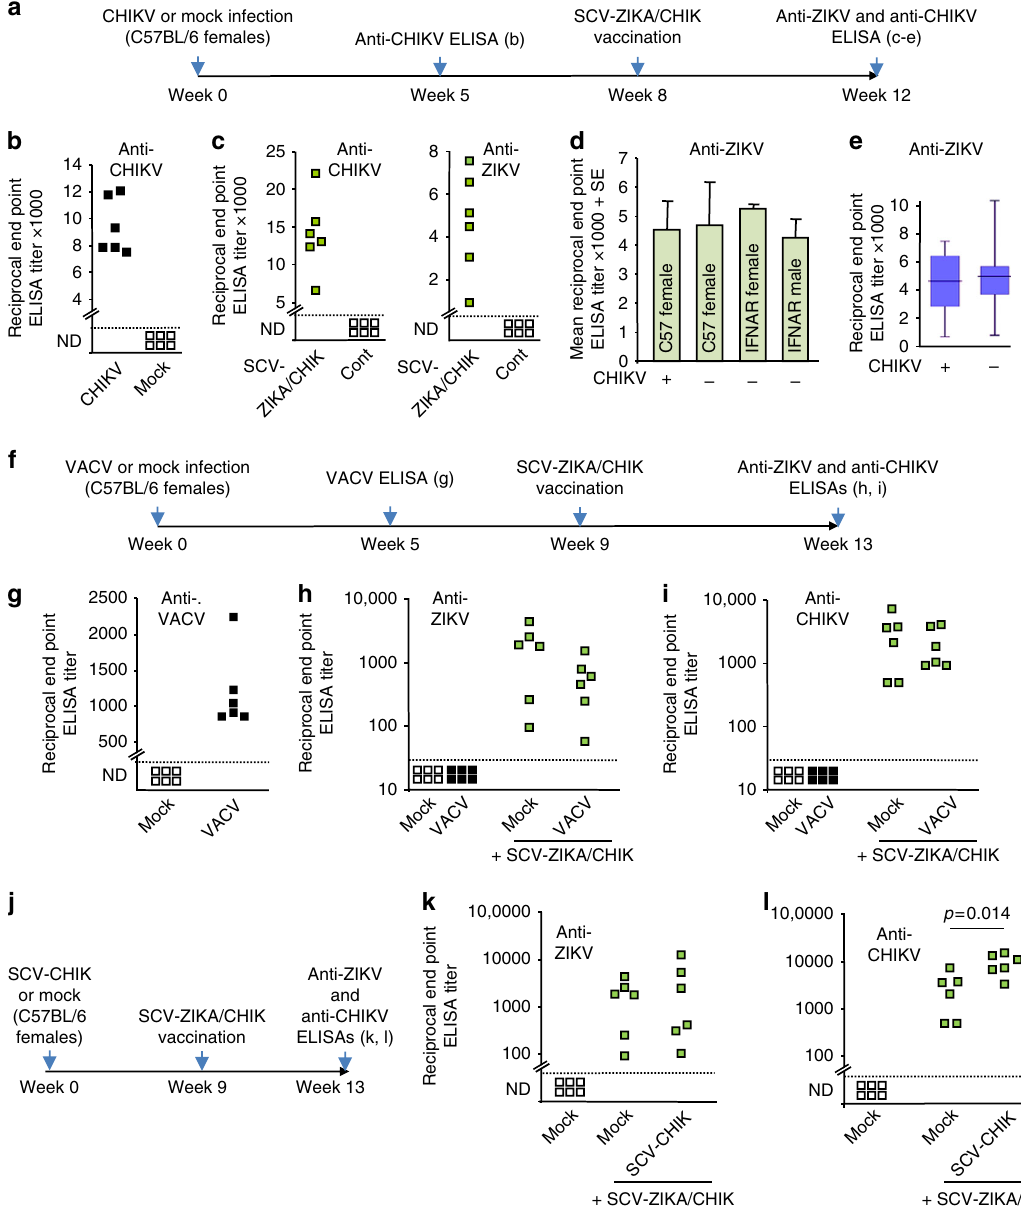
Fig. 6 Effects of prior CHIKV or VACV infections on SCV-ZIKA/CHIK vaccination. a Timeline of CHIKV infection, SCV vaccination and determination of antibody responses to ascertain whether prior CHIKV infection affects anti-ZIKV responses after SCV-ZIKA/CHIK vaccination. b Mice were infected with CHIKV or were mock infected with PBS and anti-CHIKV antibody titers determined 5 weeks post infection by ELISA ( n = 6 mice per group). c Mice that had been infected with CHIKV were vaccinated with SCV-ZIKA/CHIK and after 4 weeks anti-CHIKV and anti-ZIKV serum ELISA titers were determined. Sera from mice vaccinated with SCV-cont were included in the assays as negative controls. d Mean anti-ZIKV serum ELISA titers 4 weeks after SCV-ZIKA/ CHIK vaccination in the indicated groups ( n = 6, 6, 15, 10, left to right), either with prior CHIKV infection ( + ) or without ( − ). Error bars represent standard error of the mean. e Box and whiskers plots using the same data from d to compare anti-ZIKV ELISA titers obtained in mice that had previously been infected with CHIKV ( + ) ( n = 6) with those that had not ( − ) ( n = 31). Box — upper and lower quartile, with bar as median. Whiskers — maximum and minimum values. f Timeline of VACV infection, SCV vaccination and determination of antibody responses to ascertain whether prior VACV infection affects anti-ZIKV and anti-CHIKV responses after SCV-ZIKA/CHIK vaccination. g VACV responses after VACV infection or mock infection (PBS). h Anti- ZIKV ELISA titers obtained in mice that had previously been mock infected or infected with VACV. Also shown are responses after SCV-ZIKA/CHIK vaccination in mice that had previously received a VACV or mock infection. Limit of detection 1 in 30 dilution. i As for h except measuring anti-CHIKV ELISA titers. j Timeline of vaccinations and ELISAs to ascertain whether prior SCV-CHIK vaccination affects anti-ZIKV and anti-CHIKV responses after SCV-ZIKA/CHIK vaccination. k Anti-ZIKV ELISA titers obtained in mice that had previously been mock infected or vaccinated with SCV-CHIK and then vaccinated with SCV-ZIKA/CHIK. l Anti-CHIKV ELISA titers obtained in mice that had previously been mock infected or vaccinated with SCV-CHIK and then vaccinated with SCV-ZIKA/CHIK (statistics by t